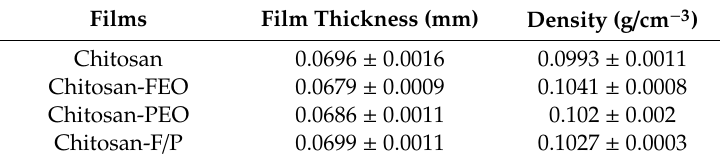
Table 1. Thickness and density of Chitosan, Chitosan-FEO, Chitosan-PEO, and Chitosan-F / P